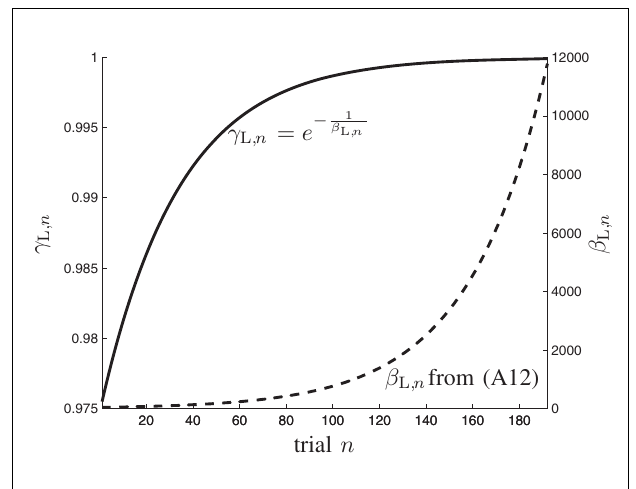
FIGUREA2 |The dynamics of the coefficients γ L, n (solid) and β L, n (dashed) over trials n = 1, ... , N , with N =